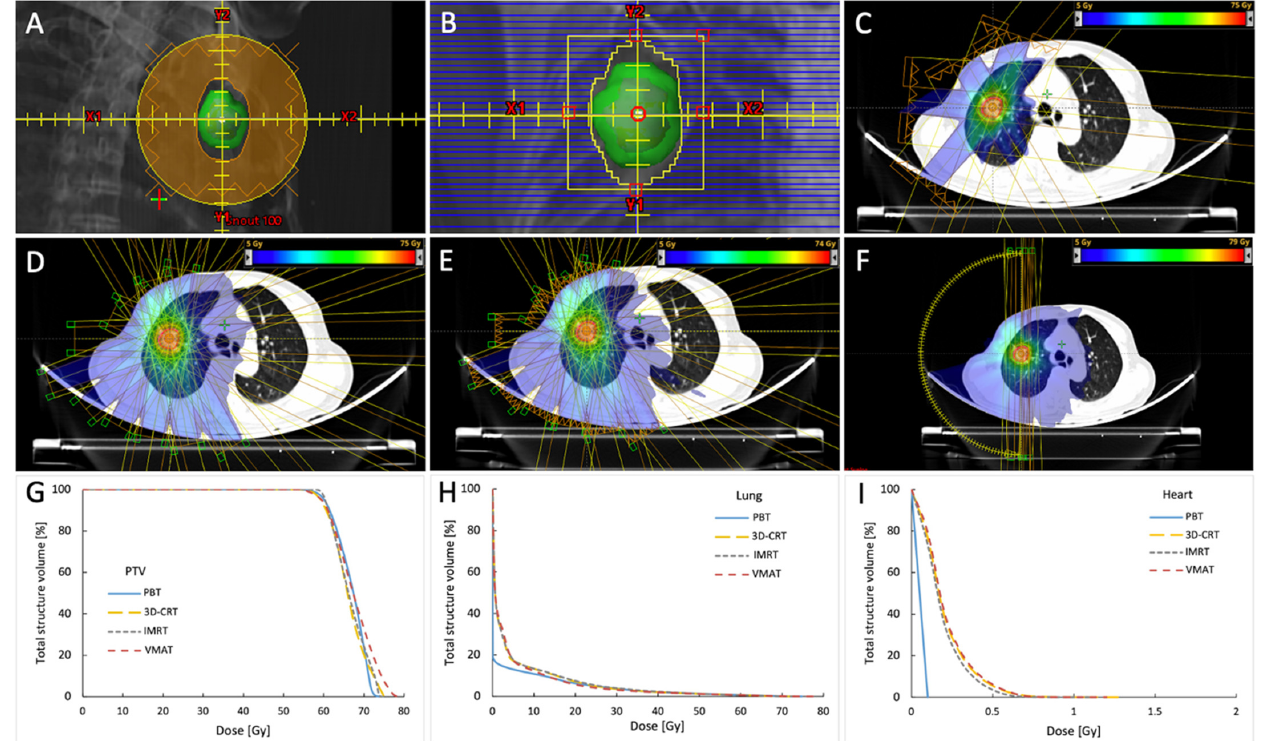
Figure 1. Examples of block and MLC settings, each treatment plan’s dose distributions and beam arrangements, and dose–volume histogram for the PTV, lung, and heart for the peripherally located tumor treated with 60 Gy in 4 fractions. The GTV is showed in red, iGTV in magenta, and PTV in green contours. Blocks were made with 1–3-mm lateral margins and 7 to 8-mm superior–inferior margins with respect to the PTV (shown in the green structure; the reddish structure inside is iGTV) ( A ). MLC was set manually for 3D-CRT, and no additional margin was added at the x-axis edges, and 0.7 cm was added to the y-axes of the MLC ( B ). Examples of dose distributions and beam arrangements for the PBT ( C ), 3D-CRT ( D ), IMRT ( E ), and VMAT ( F ) plans. Corresponding dose–volume histogram for PTV ( G ), the lung ( H ), and the heart ( I ). MLC, multileaf collimator; PTV, planning target volume; PBT, proton beam therapy; 3D-CRT, three-dimensional conformal radiotherapy; IMRT, intensity-modulated radiotherapy; VMAT, volumetric-modulated arc therapy.